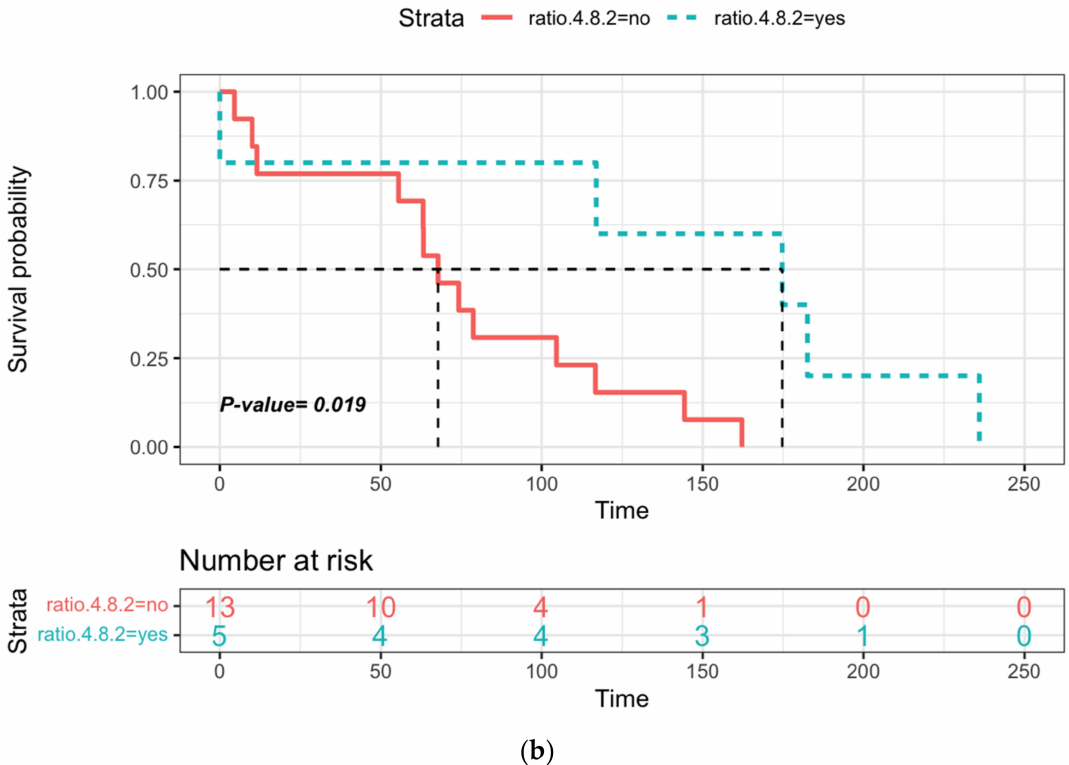
Figure 2. Time to next treatment (TTNT) in cHCL: ( a ) according to CD23 expression, ( b ) according to the CD4/CD8 T cell ratio (cut off CD4/TCD8 T cell ratio > 2). Dotted lines represent median of TTNT and PFS and red and blue areas the confidence intervals of survival